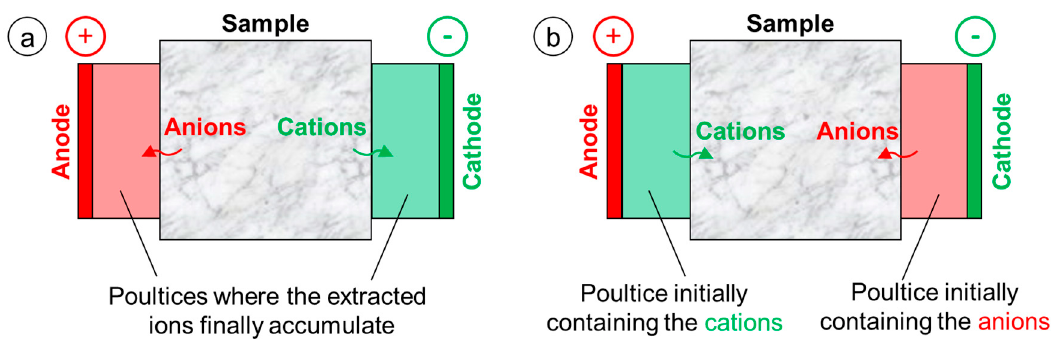
Figure 1. Schemes illustrating the setups adopted for ( a ) ion extraction from porous substrates contaminated with salts and ( b ) ion introduction into porous substrates to be consolidated.